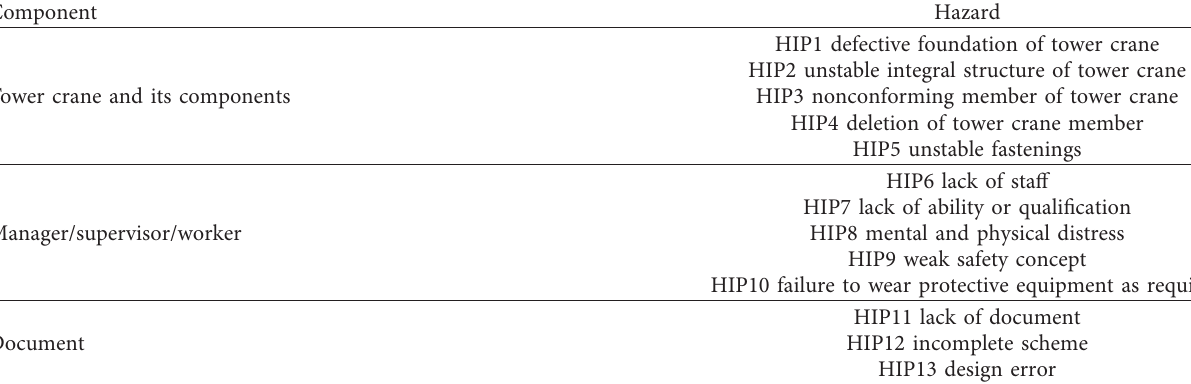
Table 4: Component failure of installation phase.